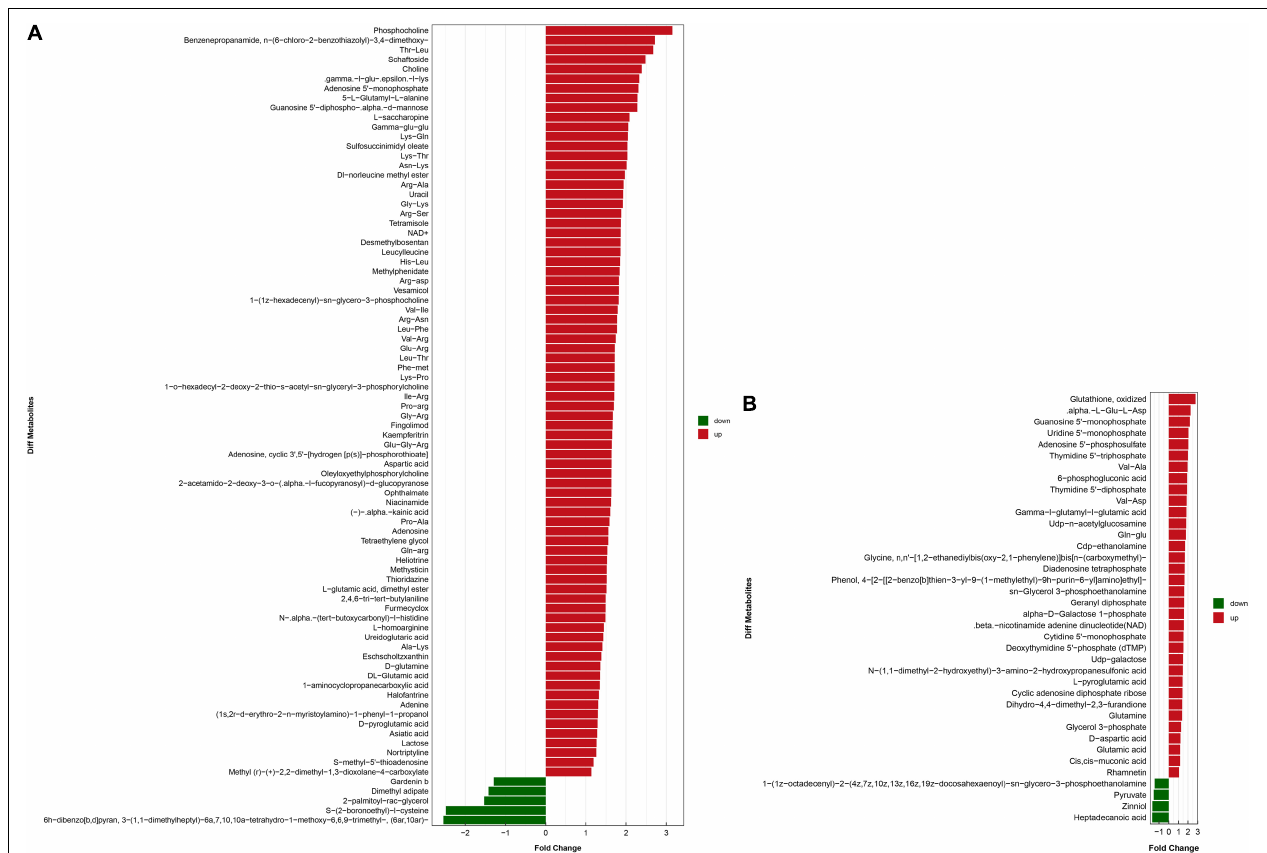
FIGURE 3 | Analysis of the multiple of the difference of metabolite expression in positive ion mode (A) and negative ion mode (B) . The X-axis indicates the differential expression multiple, red indicates that the differential expression multiple is greater than 1, and green indicates that the differential expression multiple is less than 1. The Y-axis indicates the significant difference